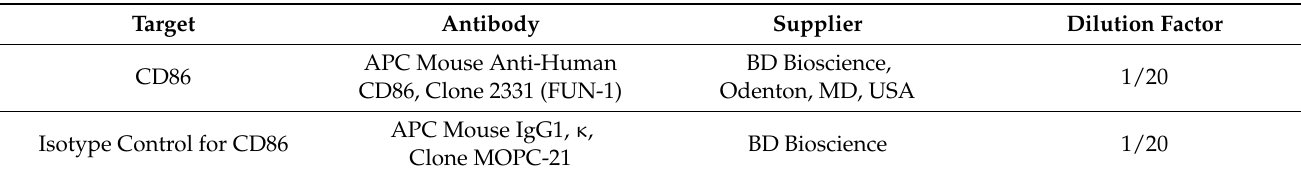
Table 1. Antibodies for Flow